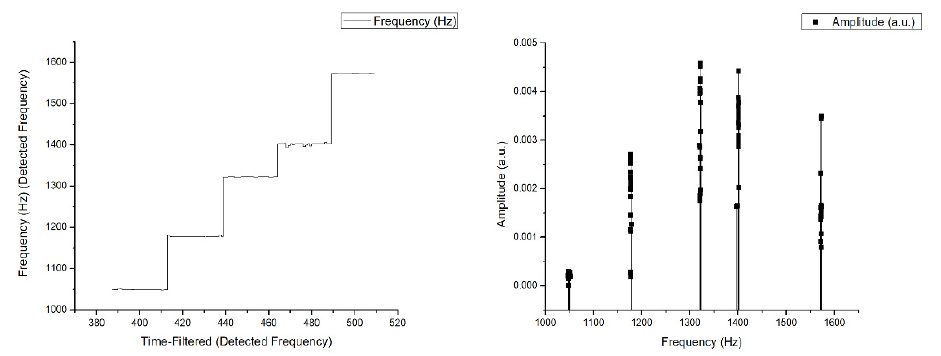
Figure 8. Experimental result for the frequency of the tone “Do Re Mi Fa Sol”.